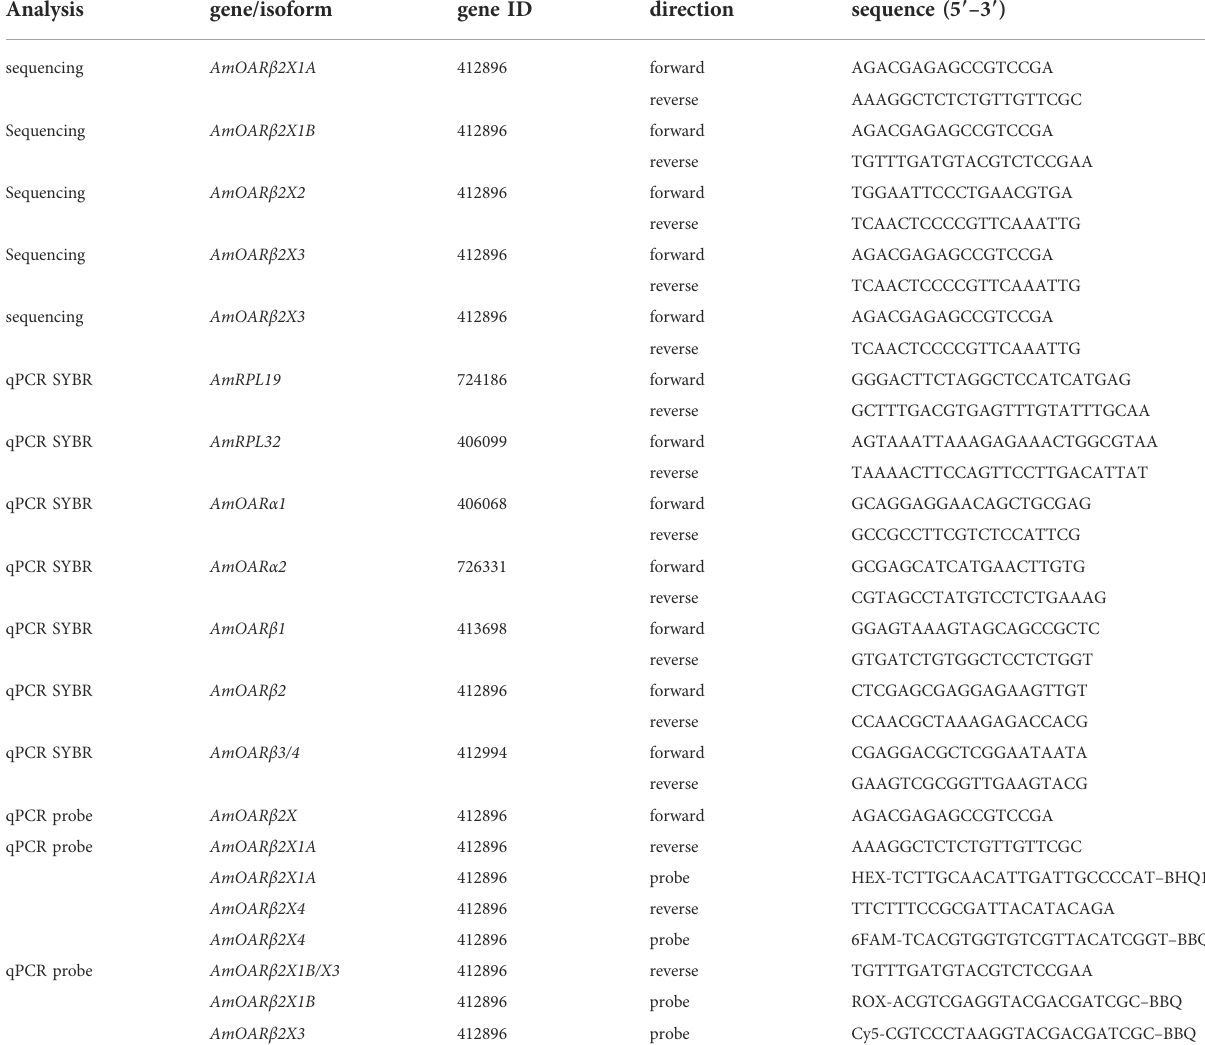
TABLE 1 Oligonucleotides used in this